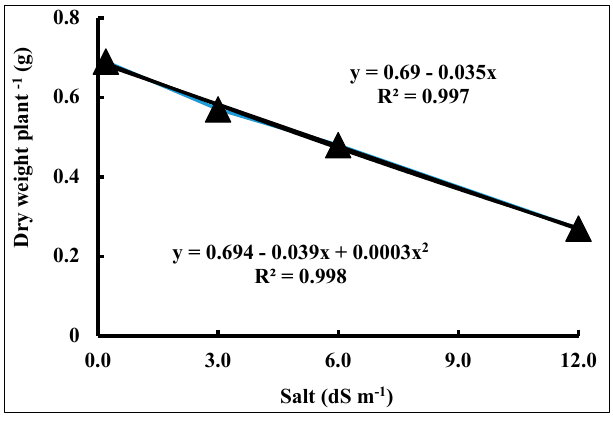
Figure 3. Dry weight of wheat ( Triticum aestivum L.) cv. Sakha 93 as a function of seawater stress for 56 days.